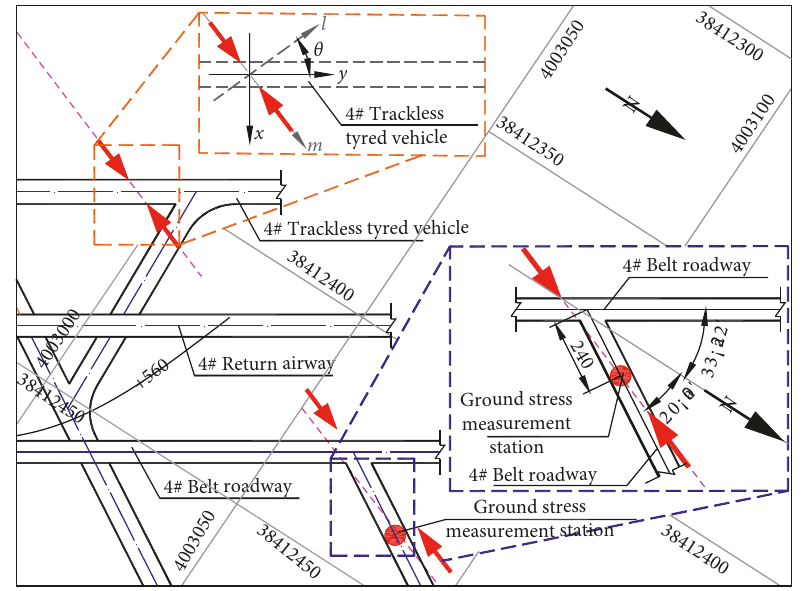
Figure 4: Measurement location and maximum horizontal stress direction of geostress in the study area.